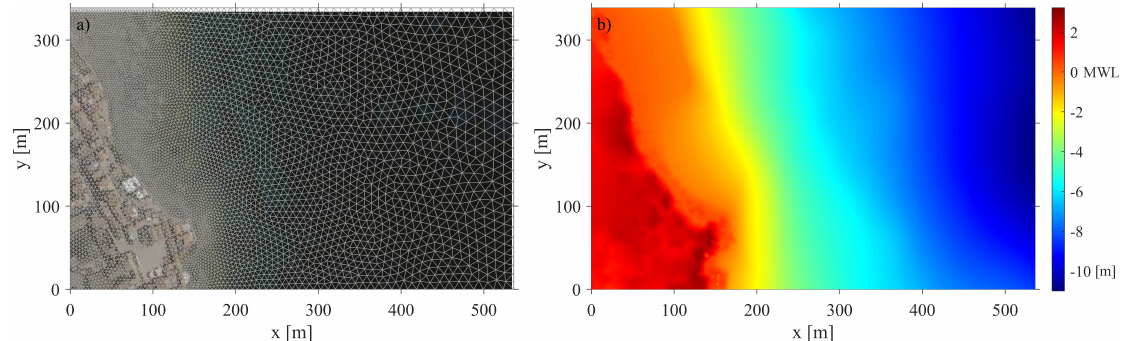
Figure 10. The Marzamemi numerical domain. ( a ) The used triangular mesh, ( b ) the bathymethry of the studied area, the color bar shows the elevation in meters above mean water level. In the subplots the coordinate origin are E = 510,569 m; N = 4,066,207 m; WGS84-UTM33N reference